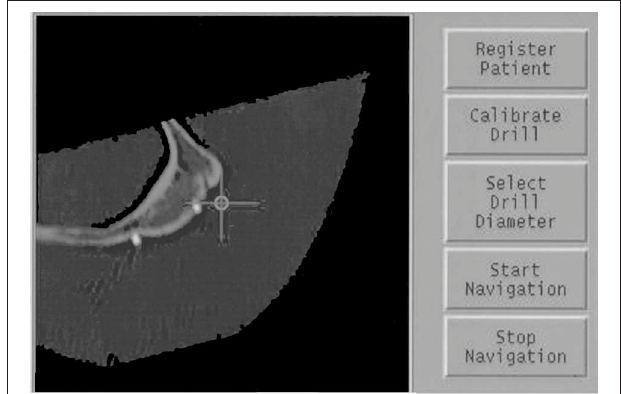
FIGURE 2 | A screenshot of fiducial markers attached to a cadaver heads zygoma. In this case, miniature titanium screws (2mm overall length, 2mm head diameter) were inserted prior to the CT scan. Localization of these fiducial markers using an optical tracking system allowed for precise registration for image-guided maxillofacial surgery. The crosshair is determined by measuring the 3D-location of a surgical probe. The multiplanar reformatted CT slice shows two titanium markers located on the zygomatic